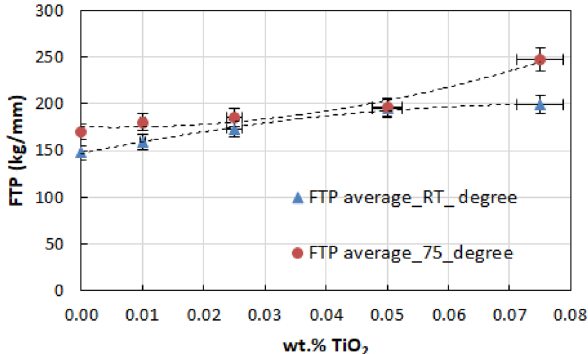
Figure 15. Plot of TiO 2 as a lubricant additive vs. flash temperature parameter FTP for different